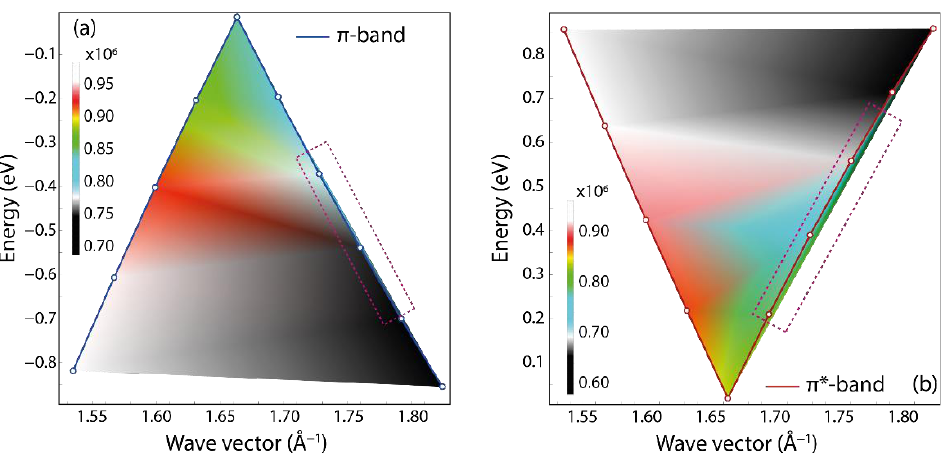
Figure 4. Fermi velocity (color bar, 10 6 m/s) as a function of energy band dispersion vs. in-plane momentum for the 𝜋 band ( a ) and 𝜋 ∗ band ( b ) in the vicinity of Κ point.